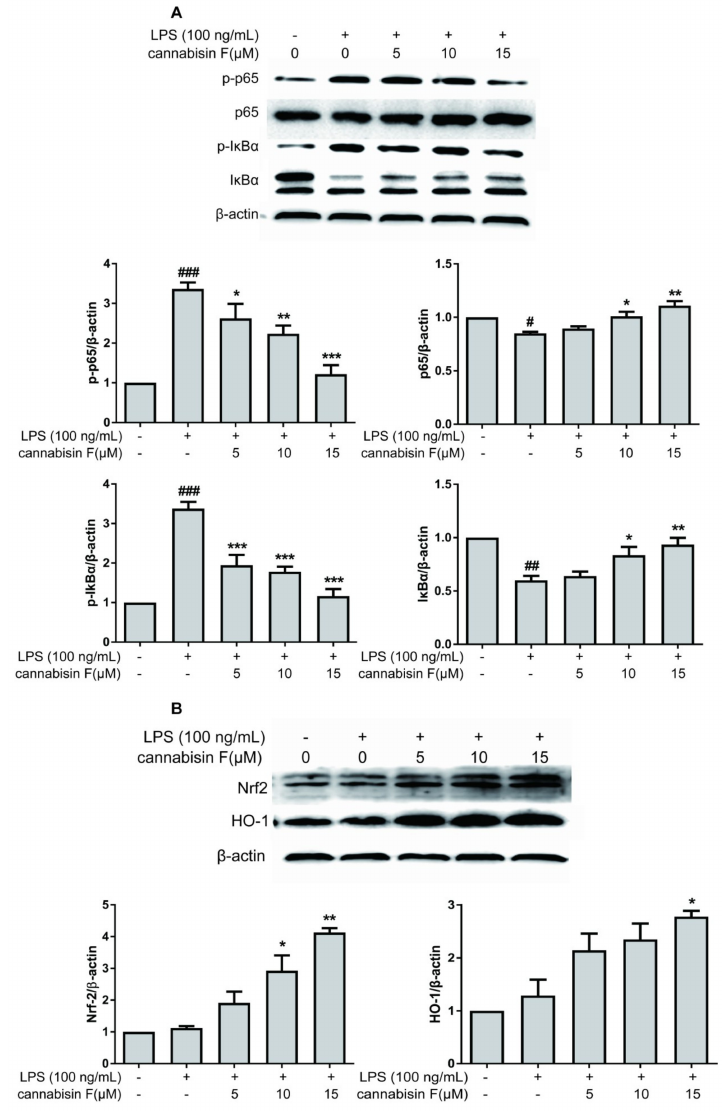
Figure 5. Cannabisin F inhibited the phosphorylation of I κ B α , p65, but enhanced the expression of Nrf2 and HO-1 in LPS-stimulated BV2 microglia cells. ( A ) BV2 microglia cells were pretreated with cannabisin F (5, 10 and 15 µ M) for 1 h prior to stimulation with LPS at 100 ng/mL for 1 h. Cell extracts were then prepared and subjected to Western blot with antibodies against I κ B α , phospho-I κ B α , p65, and phospho-p65. ( B ) BV2 microglia cells were pretreated with cannabisin F (5, 10 and 15 µ M) for 1 h prior to stimulation with LPS at 100 ng/mL for 24 h. Cell extracts were then prepared and subjected to Western blot with antibodies against Nrf2 and HO-1. β -actin was used as the internal control for normalization. The results are presented as mean ± SD from at least three independent experiments. * p < 0.05, ** p < 0.01, *** p < 0.001 as compared to the cells treated with LPS; # p < 0.05, ## p < 0.01, ### p < 0.001 as compared to the